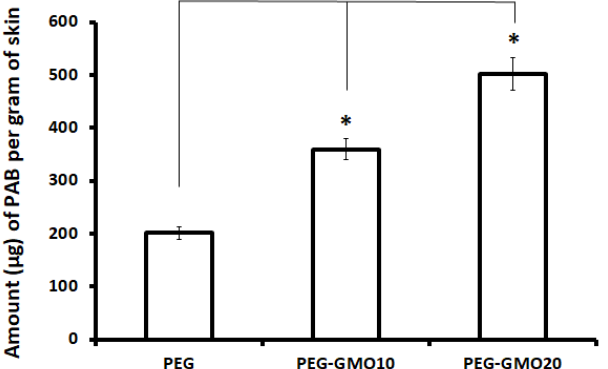
Figure 5. PAB accumulation in the skin (expressed as the amount (µg) of PAB per gram of skin) following 8 h of treatment with PEG, PEG-GMO10, and PEG-GMO20 formulations. Each column reflects the mean ± S.E. of three experiments. *: p < 0.05 significantly different from PEG (Student’s t -test).